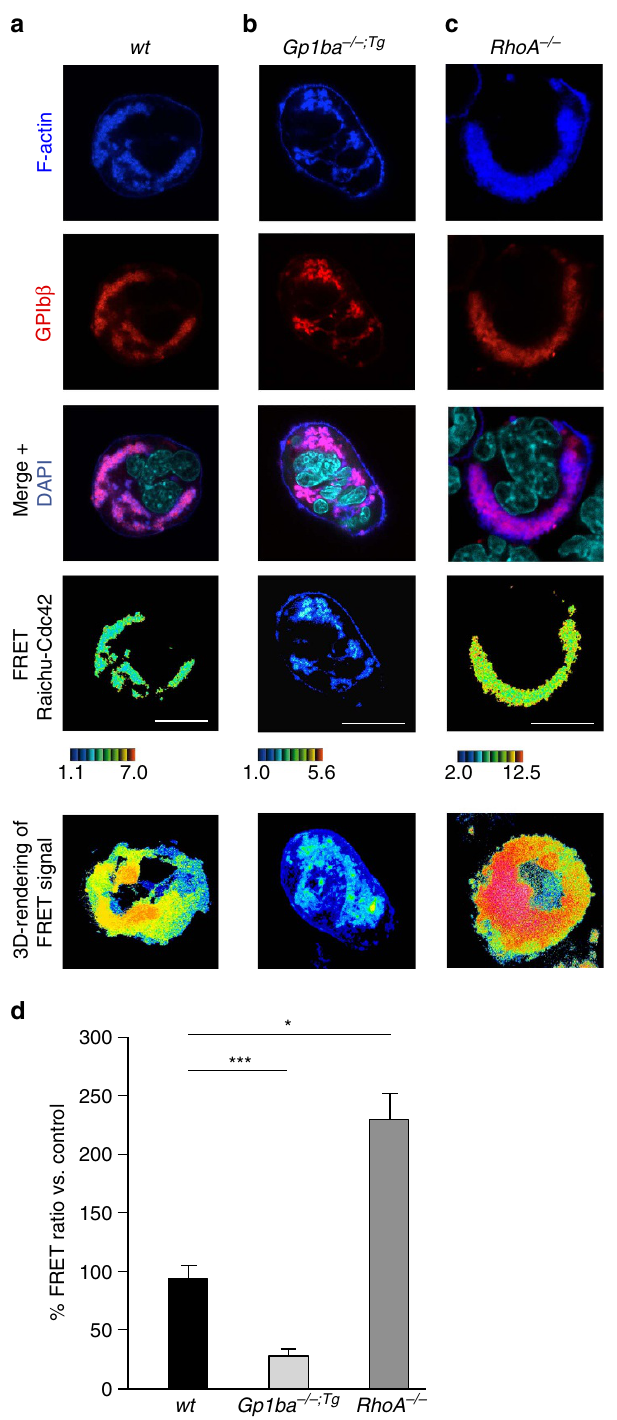
Figure 6 | RhoA controls GPIb a -induced MK polarization by limiting Cdc42 activity. ( a – c ) Cultured mouse MKs were transduced with Raichu-Cdc42 lentiviral vector. F-actin was stained with phalloidin (blue); GPIb b , red; DAPI, cyan. Cdc42 activation was visualized by colour-coded FRET. High ratio values (red) correlate with higher Cdc42 activity. Active Cdc42 localizes with the polarized F-actin/DMS complex and its activity is decreased in Gp1ba (cid:2) / (cid:2) ;Tg ( Gp1ba-Tg ) and increased in RhoA (cid:2) / (cid:2) MKs. Scale bar: 10 m m. ( d ) Quantification reveals decreased Cdc42 activity in Gp1ba (cid:2) / (cid:2) ;Tg (light grey) and increased activity in RhoA (cid:2) / (cid:2) (dark grey) polarized MKs compared to the wt (black) ( n ¼ 4 biological replicates). Bar graphs represent mean ± s.d. Two-way ANOVA with Bonferroni correction for multiple comparisons; * P o 0.05; *** P o